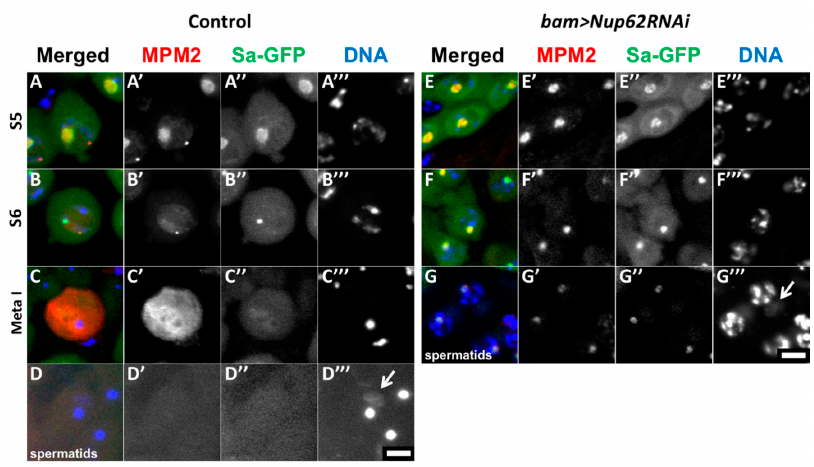
Figure 2. Depletion of Nup62 complex components resulted in inhibition of CDK1 activation. ( A – G ) Immunostaining of spermatocytes at later stages with anti-MPM2 antibody, which detects protein phosphorylation by CDK1. Anti-MPM2 immunostaining (red in ( A – G ), white in ( A’ – G’ )), Sa-GFP fluorescence as a marker to determine the developmental stages of spermatocytes (green in A-G,